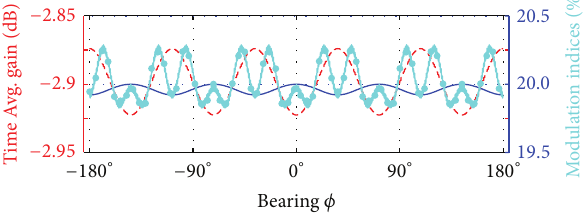
Figure 6: Time-averaged co-pol array gain (dashed curve using same normalization as Figures 3 and 4) and modulation indices for the 15 Hz (solid curve) and 135 Hz (knobby curve) components of the AM signal.